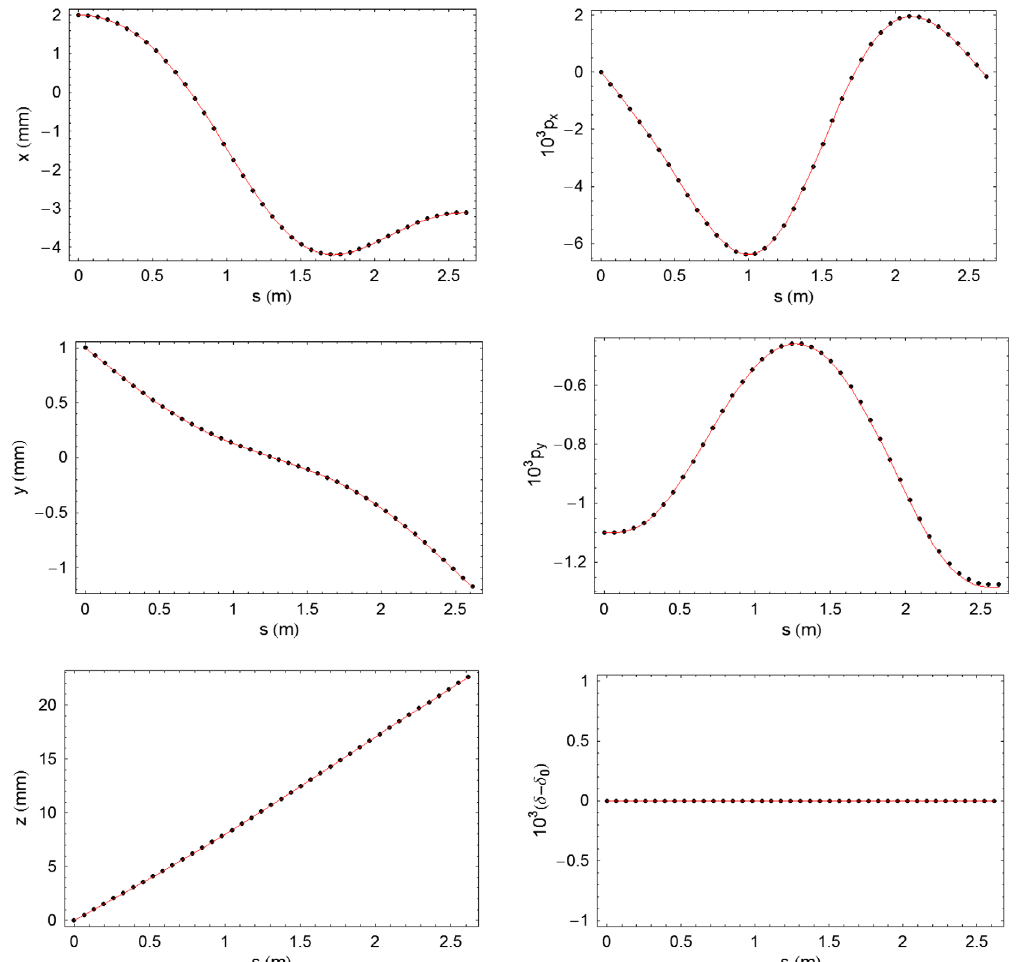
FIG. 7. Results of tracking a particle through the field of a curvilinear electrostatic quadrupole. The potential is given by Eq. (95). The black points show the results from the explicit symplectic integrator described in Sec. III. The red lines show the results from numerical integration of the equations of motion derived from the Hamiltonian